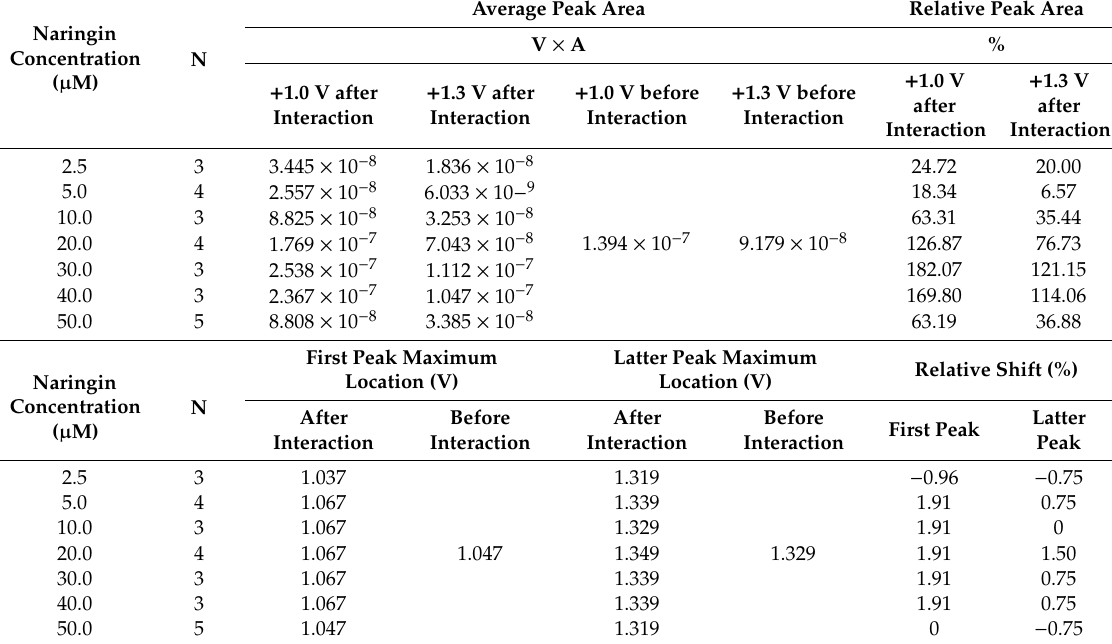
Table 3. Electrochemical parameters describing the naringin-dsDNA interaction.